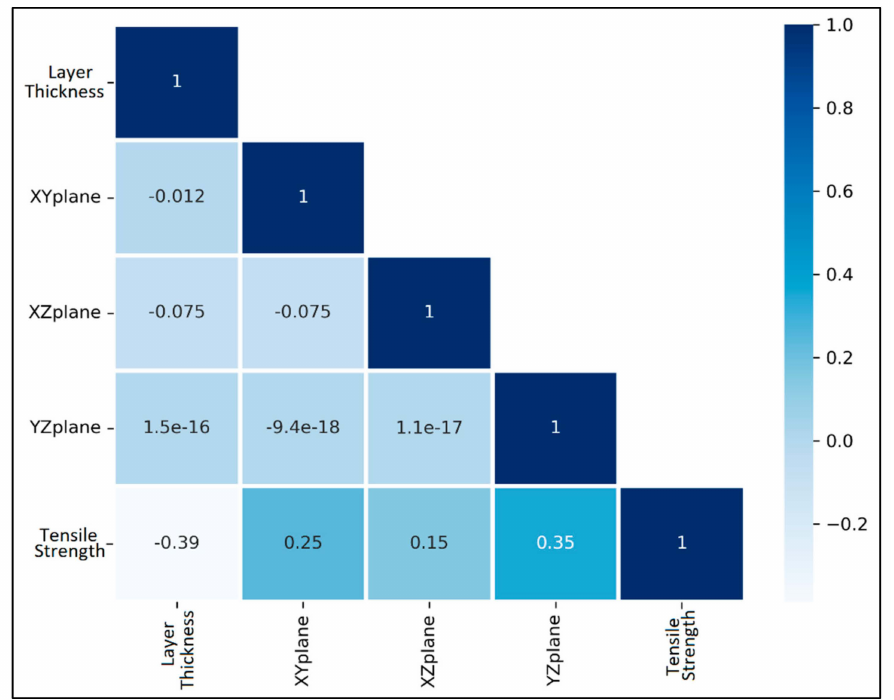
Figure 6. Pearson correlation heatmap for process parameters and tensile strength for case study